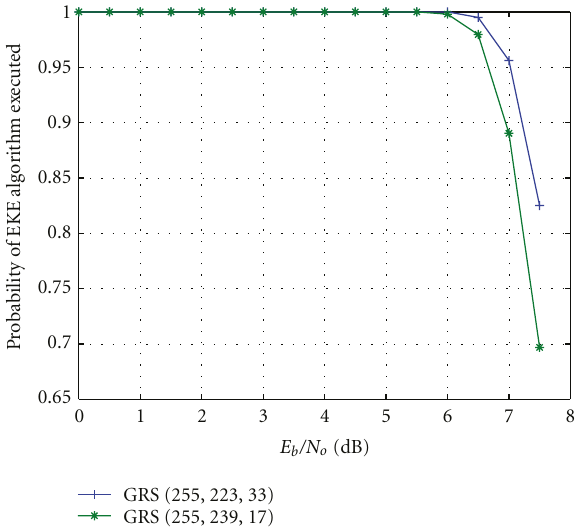
Figure 2: Probability of the EKE algorithm in listing decoding, when a (255, 233, 33) GRS code and a (255, 239, 17) GRS code are transmitted with BPSK signaling over AWQN